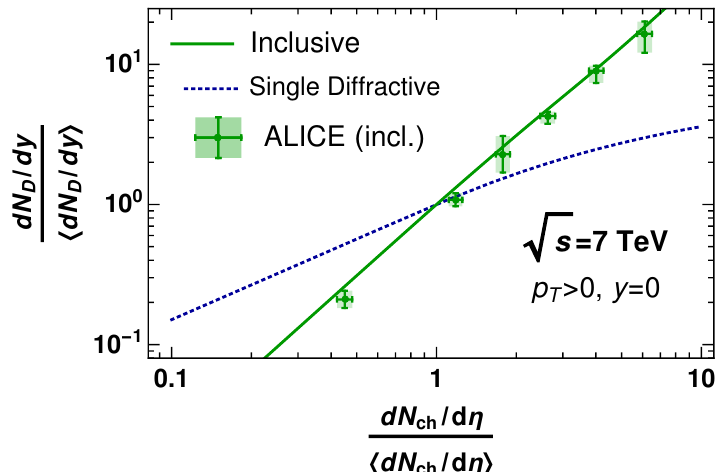
Figure 2: Results for the multiplicity dependence of inclusive and single diffractive production of D -mesons in LHC kinematics. For inclusive production we take into account both prompt and nonprompt mechanisms. The experimental data are for the multiplicity dependence of inclusive production from ALICE [ 1 ] , and it is assumed that all particles are collected at central rapidities in rapidity window | y | , | η | (cid:174)